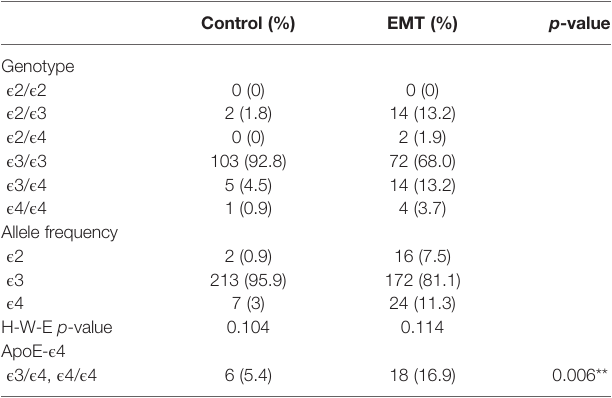
TABLE 3 | FSH/LH/E2 levels in the control group and patients with EMT. Parameters Control ( n = 111)